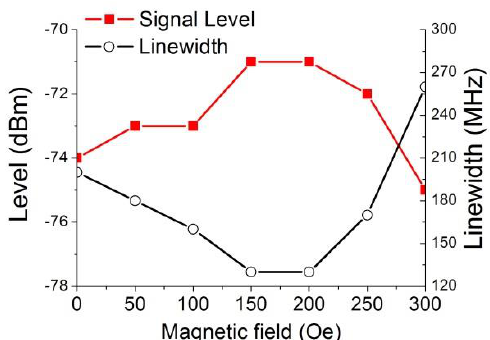
Figure 3. The signal level and linewidth of the spintronic oscillation depending on magnetic field at the condition of IDC = 1.5 mA. (1 Oe (Oersted) = 1 Gauss in air = 0.1 millitesla).